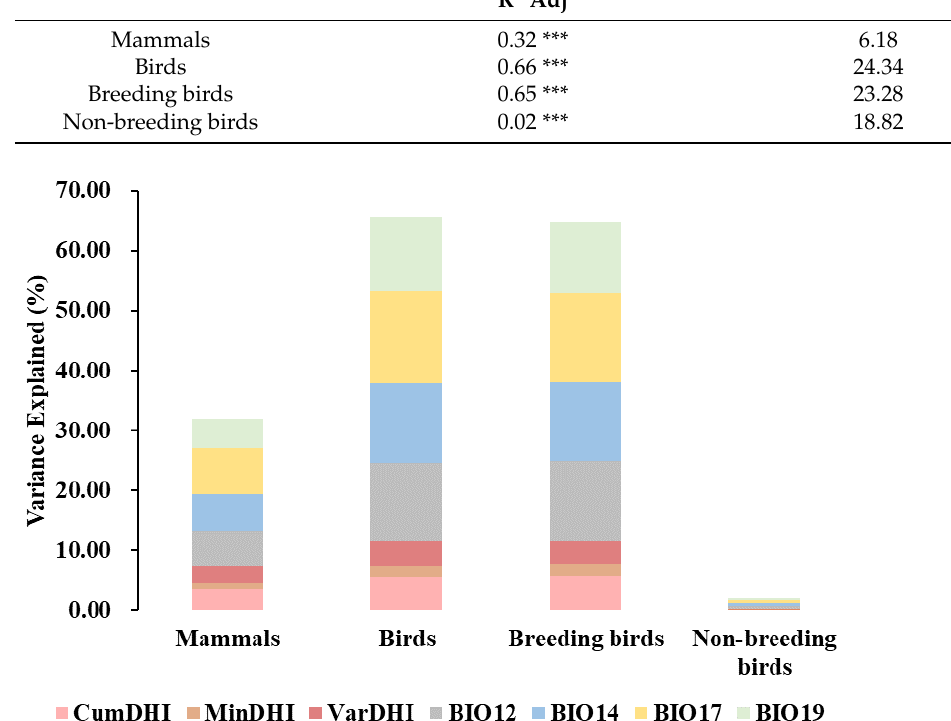
Figure 9. The relative importance of (the) three FPAR-based DHIs, as well as four Bioclim variables to the four